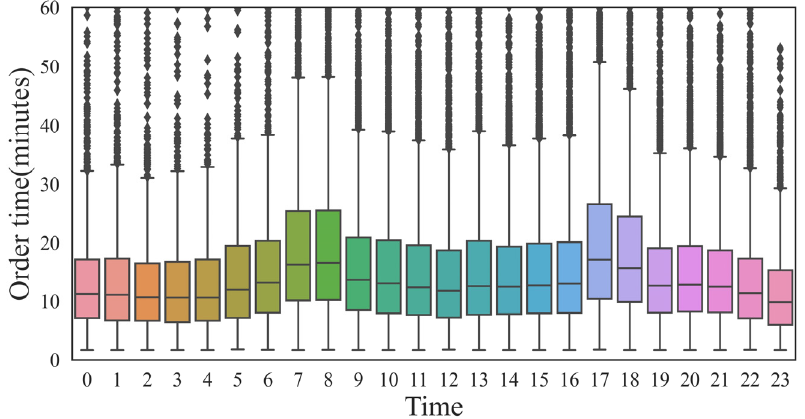
Figure 5. Order time consumption.